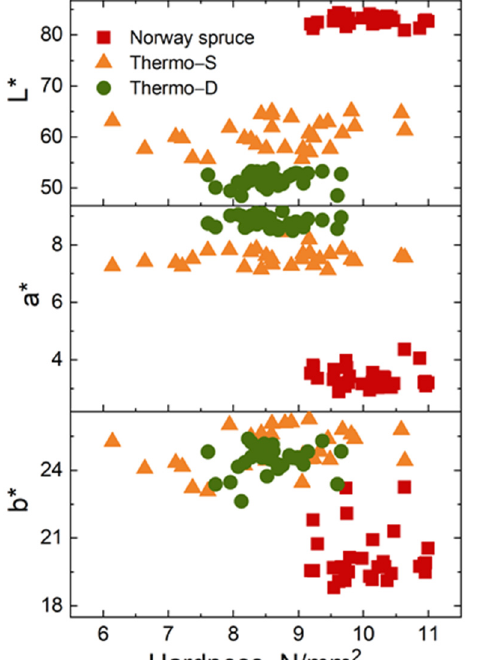
scores for untreated and ThermoWood ® Norway spruce and Scots pine.